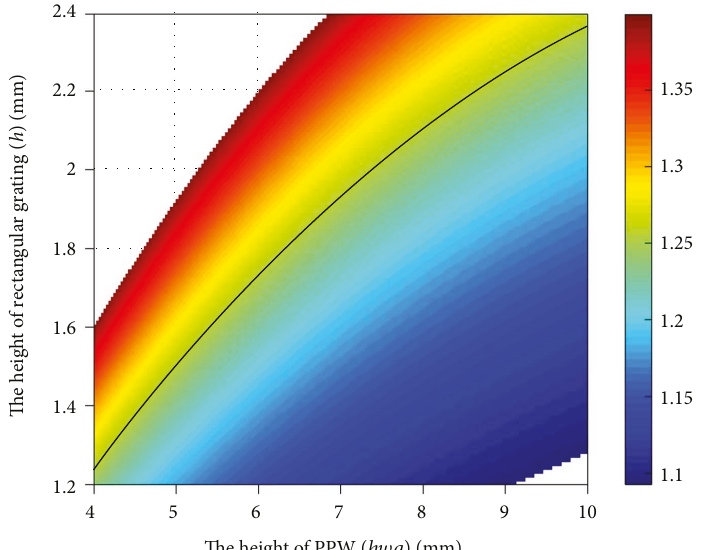
Figure 7: The relation among ε